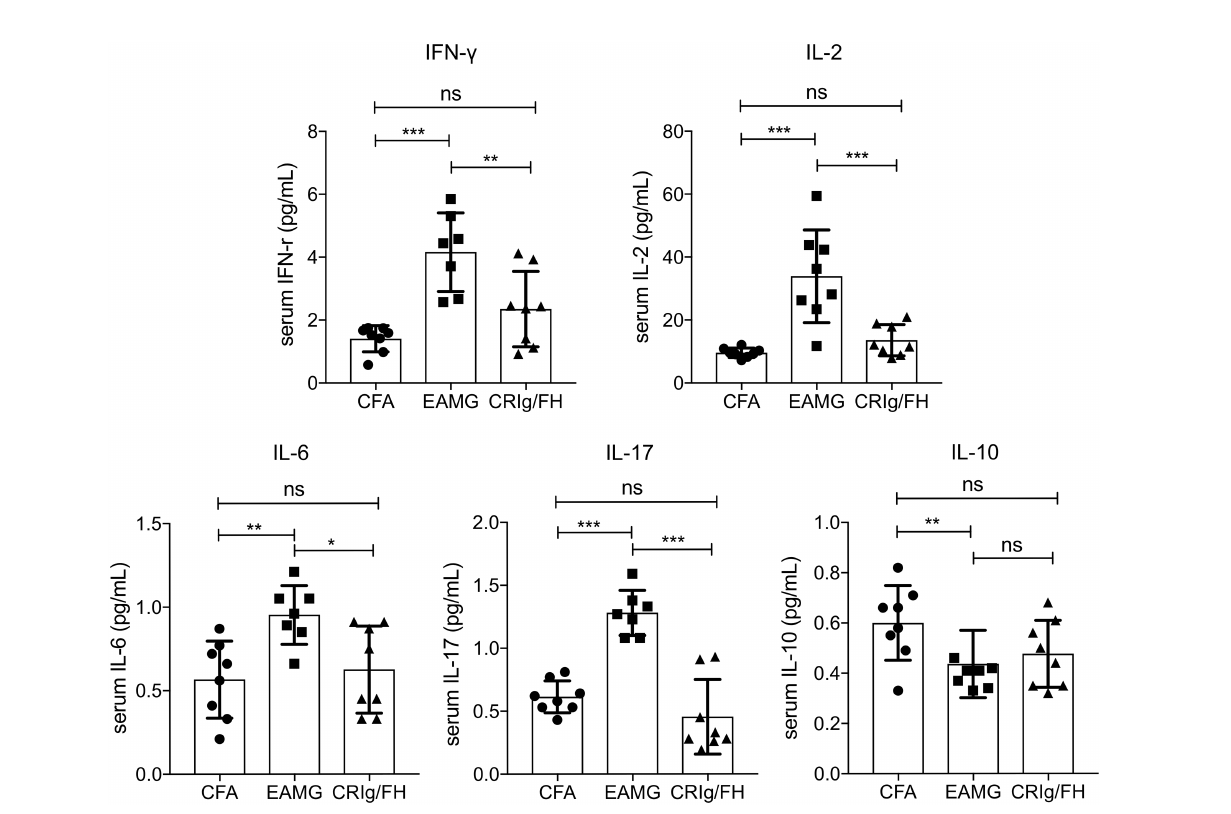
FIGURE 4 | The effect of CRIg/FH treatment on cytokine production in active EAMG rats. Rat sera were collected to measure the concentrations of the cytokines of IFN- g , IL-2, IL-6, IL-10, and IL-17. Data are presented as mean ± SD. Statistical signi fi cance was assessed by one-way ANOVA test with Tukey ’ s multiple comparison test; n = 7 – 8/group; ns, not signi fi cant, * p < 0.05, ** p < 0.01, *** p <